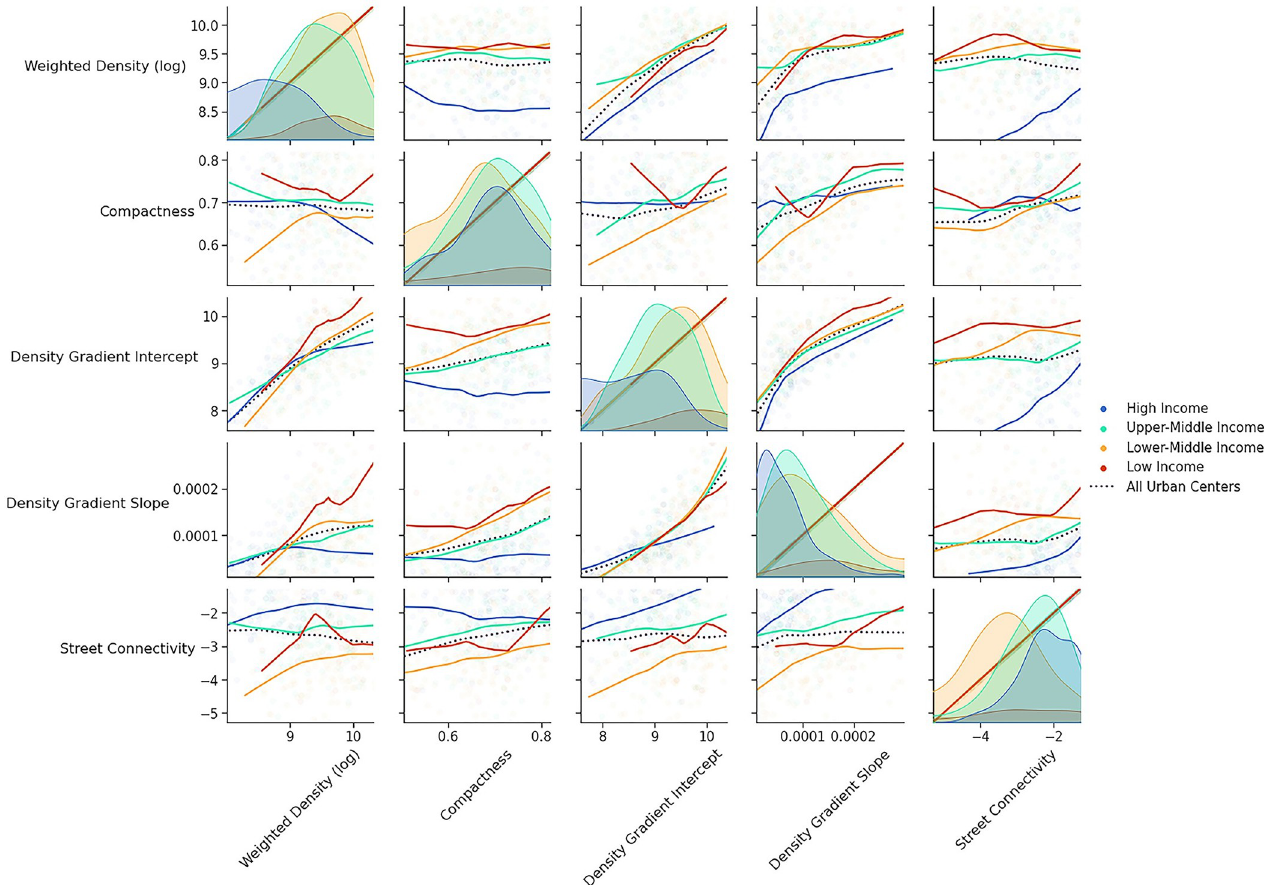
Fig 3. Correlation of urban form metrics across income